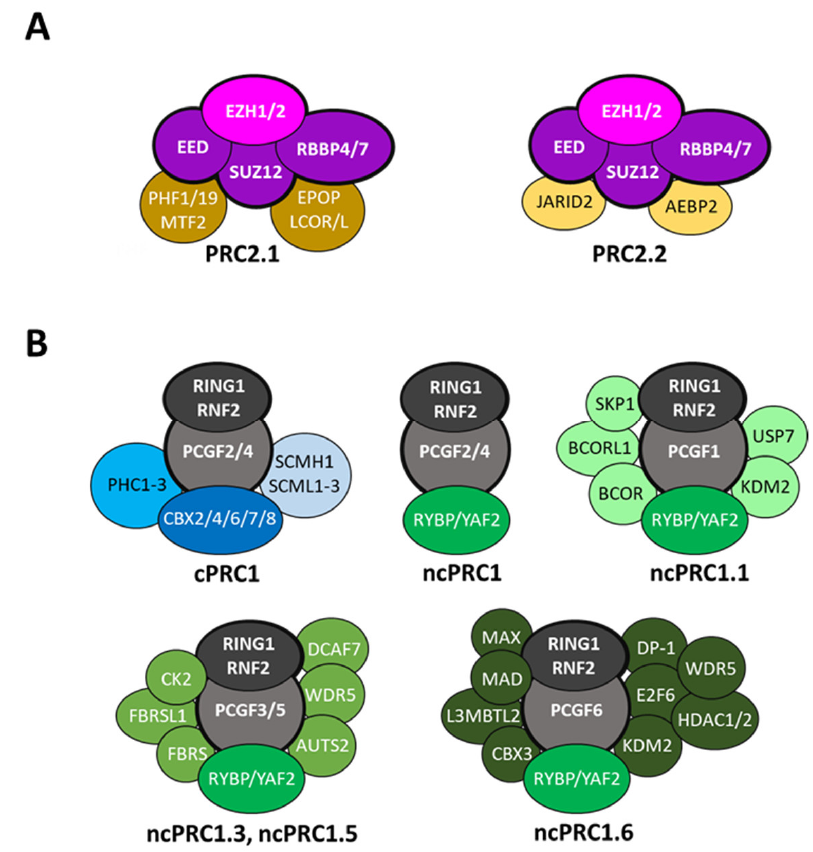
Figure 1. The mammalian Polycomb repressive complexes. ( A ) PRC2 is composed of four core subunits, EZH1/2, EED, SUZ12 and RBBP4/7, and is classified as two distinct complexes, PRC2.1 and PRC2.2 based on the auxiliary proteins associated. ( B ) The core PRC1 complex is composed of RING1 or RNF2 associated with one of the six PCGF proteins. Canonical PRC1 (cPRC1) includes PCGF2 or BMI1 (PCGF4), one of the chromobox proteins (CBX2, CBX4, CBX6-8), a polyhomeotic protein (PHC1/2/3) and eventually an SCM protein (SCMH1 or SCML1/2/3). In contrast, non-canonical PRC1 (ncPRC1) can include all PCGF proteins (PCGF1/2/3/4/5/6) associated with RYBP or YAF2. The identity of the PCGF subunit imposes the nature of the auxiliary proteins present in the assembly, thus defining diverse distinct ncPRC1